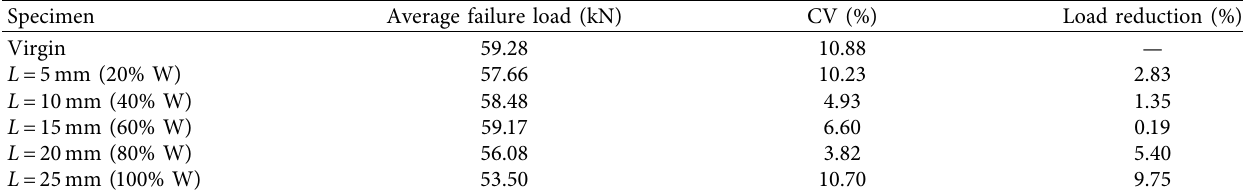
Table 2: Bearing capacity loads compared between different scratch lengths and virgin specimen.